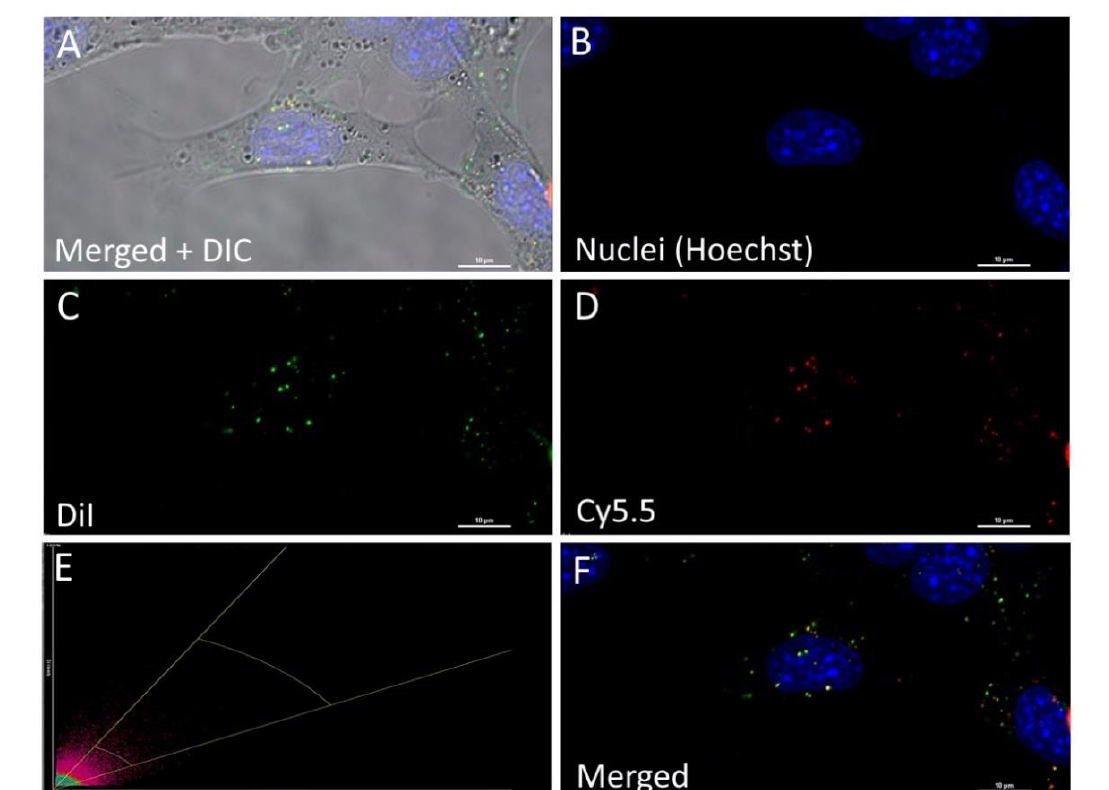
Table 5. Characteristics of fluorescent PLGA NPs used in in vitro experiments.